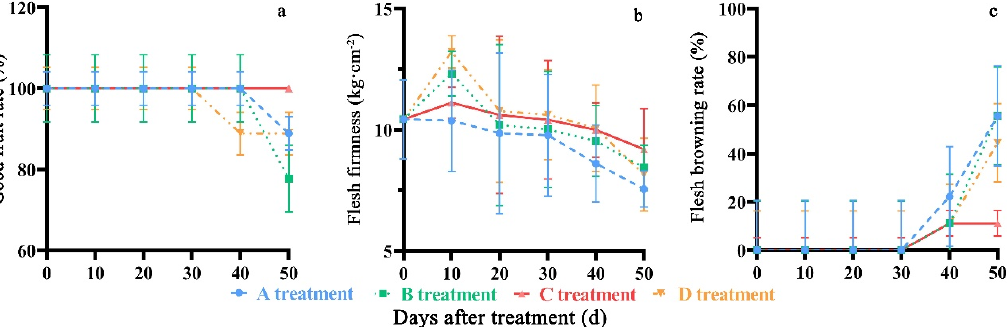
Figure 3. Changes in good fruit rate ( a ), fruit firmness ( b ) and flesh browning rate ( c ) of ‘Yonglian No.1’ peach fruits during storage in four treatments. Vertical bars represent the standard errors. The different lower case letters at each time point indicate a significant difference at p < 0.05 using Duncan’s multiple range tests.